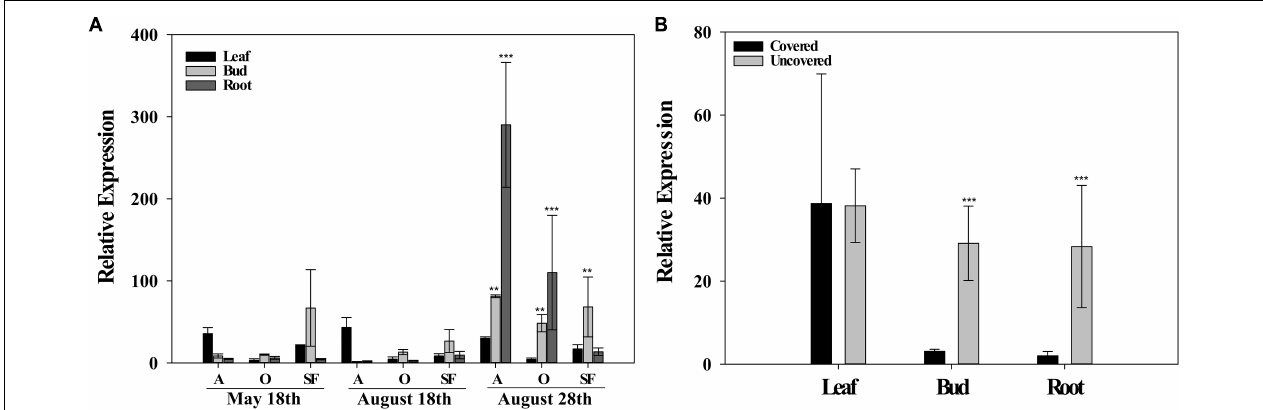
FIGURE 3 | Relative expression of the lysine histidine transporter ( LHT)1 . (A) Field experiment I for the leaves, buds, and roots in rainy period (May 18th), dry period (August 18th), and re-watering period (August 28th) for Acauã (A), Oeiras (O), and Semperflorens (SF). (B) LHT1 relative expression in leaves, buds, and roots for field experiment II in re-watering period (August 28th) for Covered and Uncovered plants of coffee cultivar Paraiso 2. Data are means ± 95% SD of the mean ( n = 6). ** = significative difference of tissues between periods and *** = high significant difference of tissues between periods.